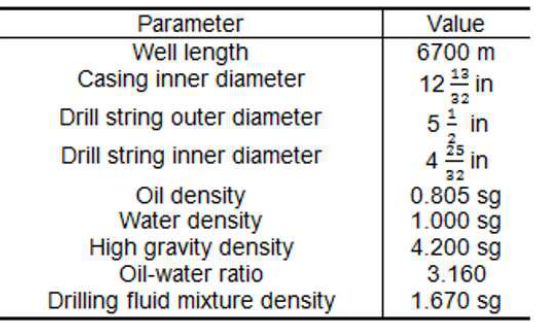
Table 1: Well geometry and fluid